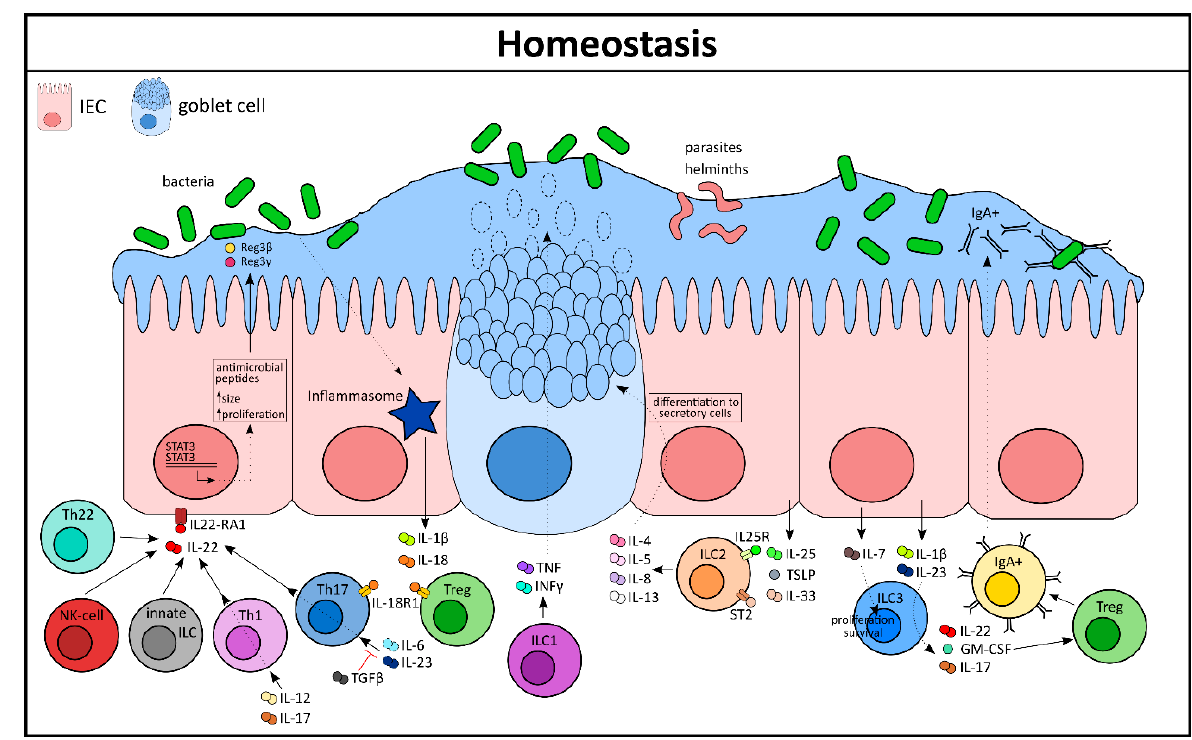
Figure 1. Immune–epithelial crosstalk as a guardian of intestinal homeostasis. GM-CSF, granulocyte-macrophage colony- stimulating factor; IEC, intestinal epithelial cell; ILC, innate lymphoid cell; NK-cell, natural killer cell; STAT, signal transducers and activators of transcription; Th, T helper cell; Treg, regulatory T-cell; TSLP, thymic stromal lymphopoietin.